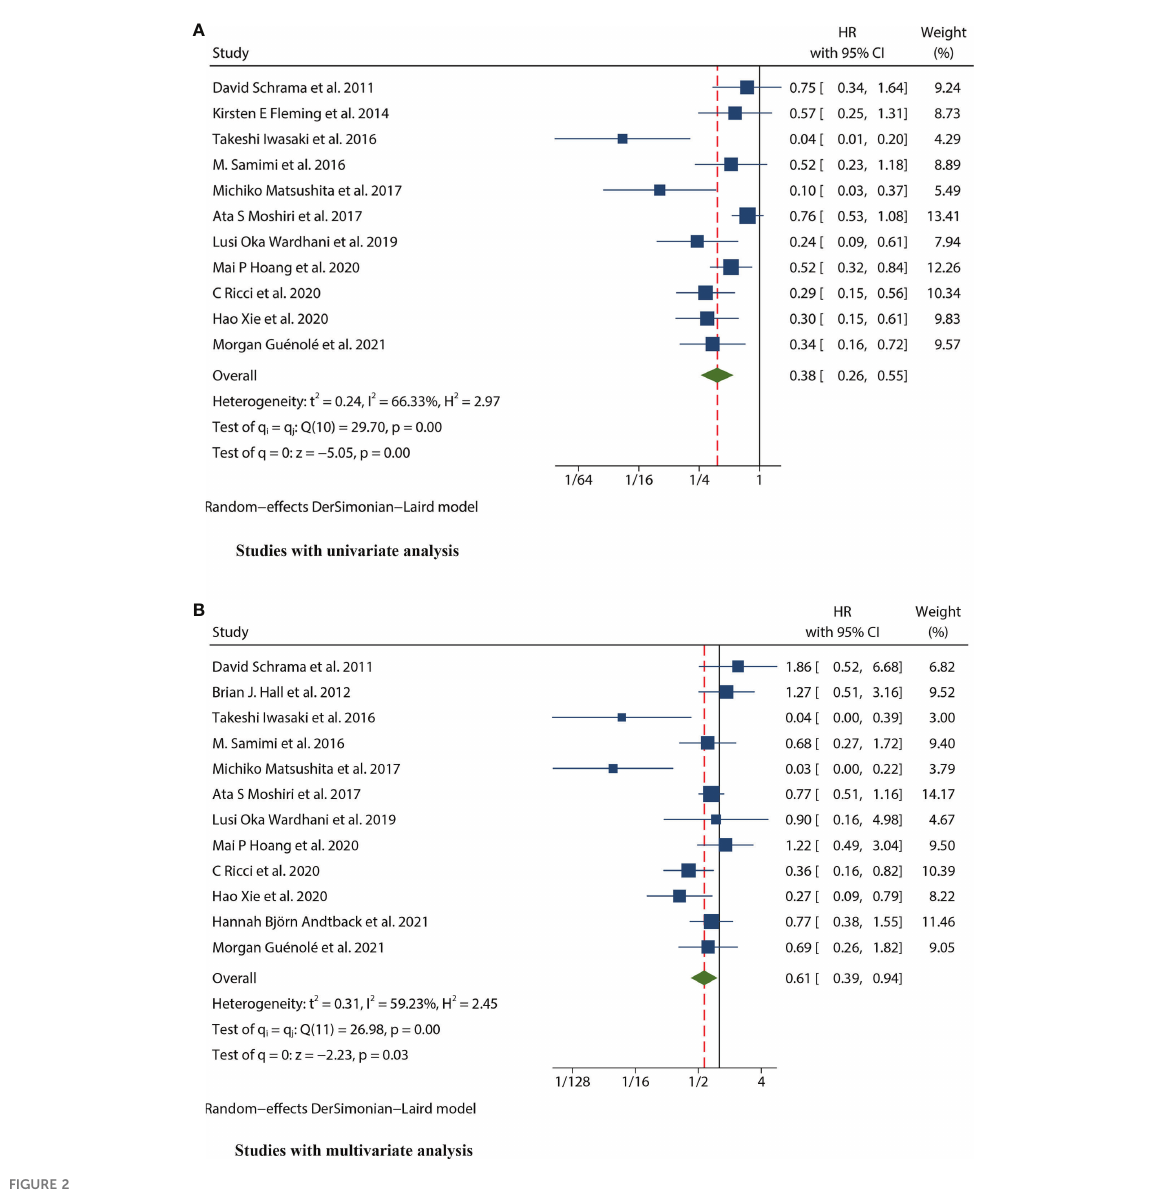
FIGURE 2 Forest plot of the hazard ratio for the association between the MCPyV and overall survival (OS) in patients with Merkel cell carcinoma. (A) univariate analysis. (B) multivariate